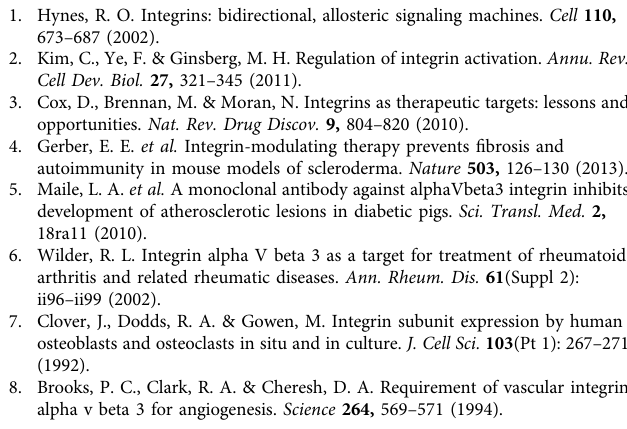
Table 2 list all relevant peptide crosslinks by BS2G. Crosslinking by glutaraldhyde (Supplementary Fig. 3A). His-ProAgio was mixed with recombinant integrin a v b 3 in 0.7:1 ratio in HEPES buffer. The freshly prepared glutaraldhyde was added into the mixture in three folds of molar